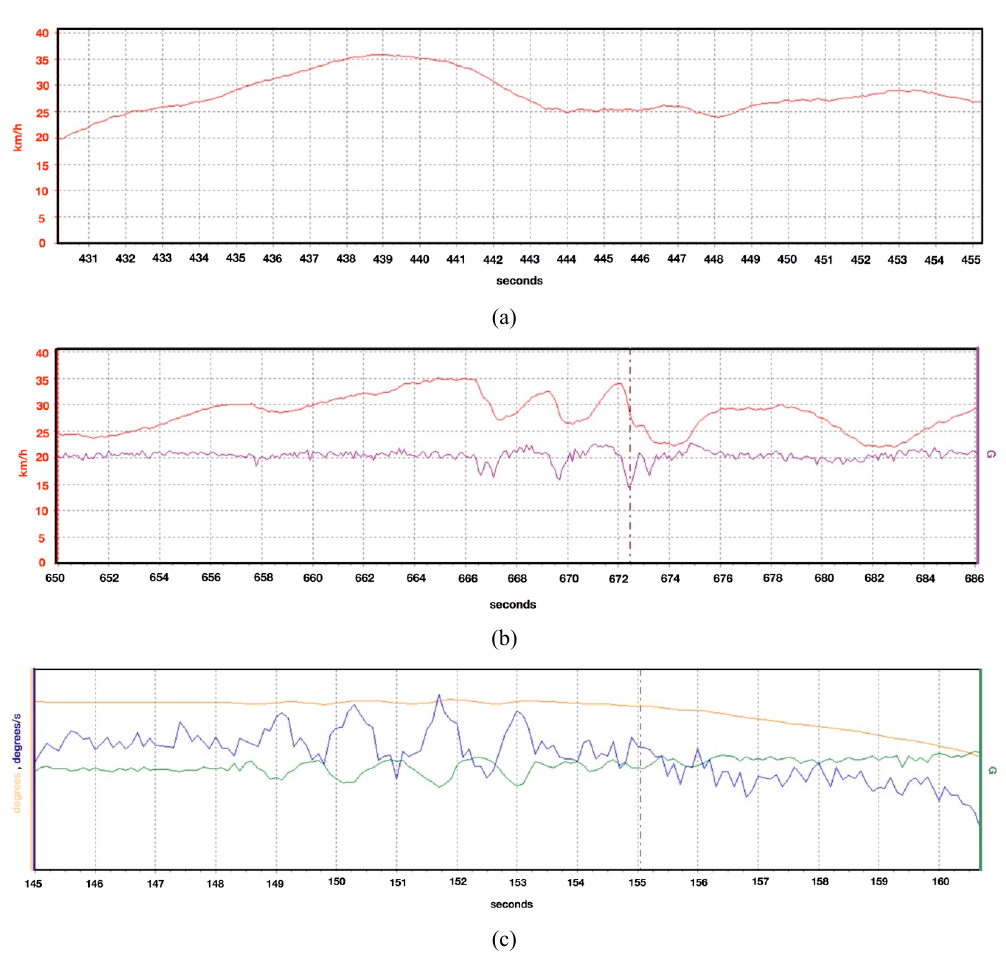
Figure 2. VTS signals: ( a ) Speed (red); ( b ) Speed (red) and Longitudinal Acceleration (purple); and ( c ) Heading (orange), Yaw Angle Rate (blue) and Lateral Acceleration (green).